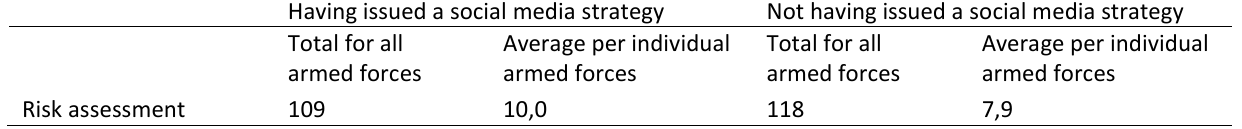
Table 7. Risks related to the existence of a social media